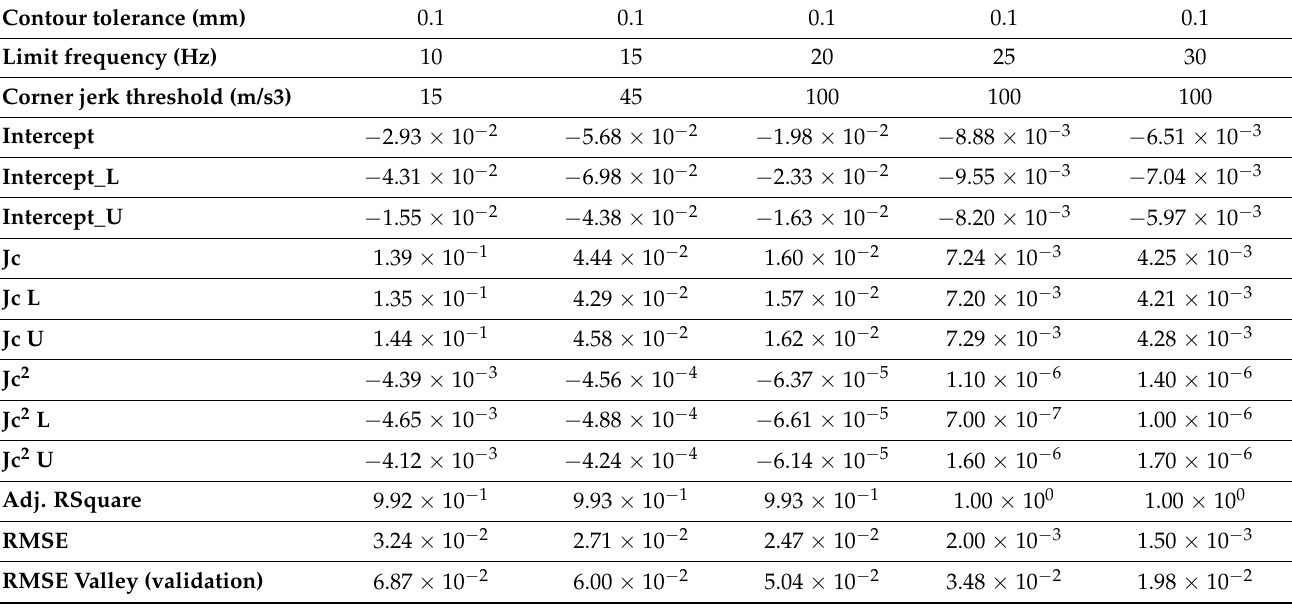
Table A4. Parameters of regression models that describe the dependence of the TV coefficient on the corner jerk limit (denoted by J c ), results for contour tolerance of 100 µ m. Postfixes L and U denote the lower and upper limits of the 95% confidence intervals,